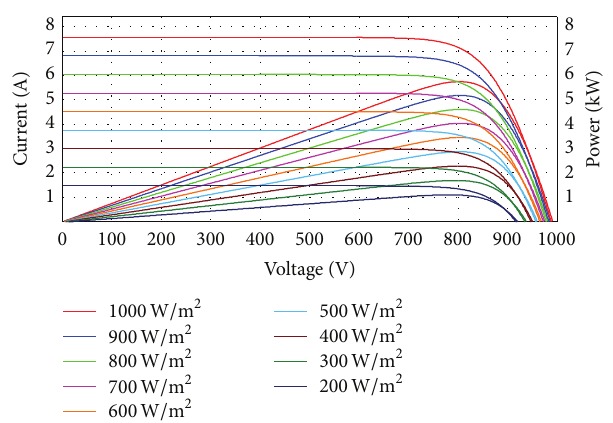
Figure 1: 𝐼 - 𝑉 and 𝑃 - 𝑉 curve with different irradiation.